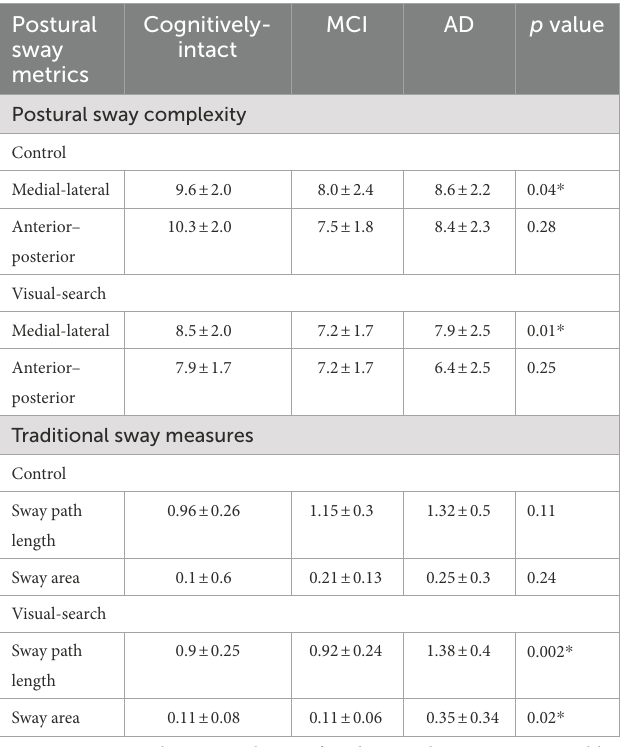
Accuracy on the visual-search task did not differ between groups